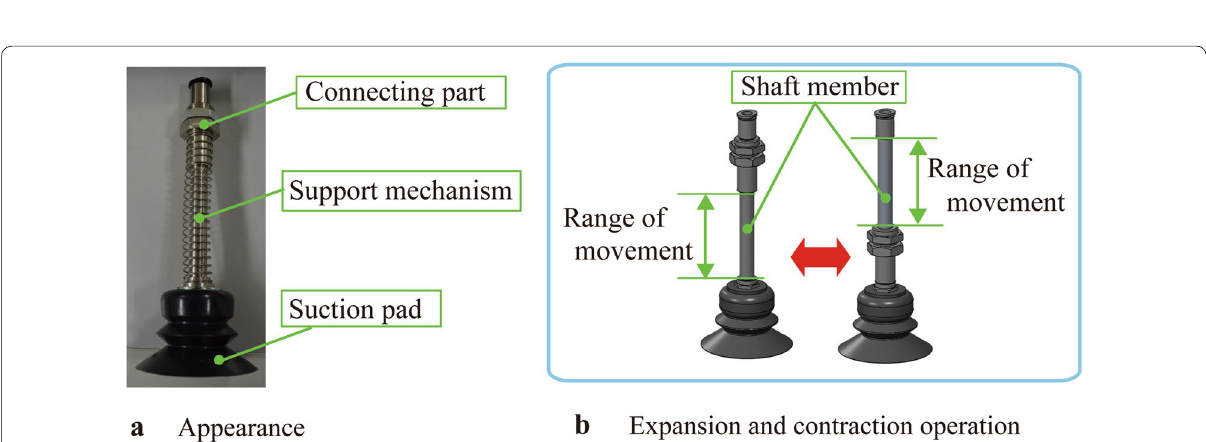
Fig. 5 Conventional suction pad units (VPC 50-50 BN 6 JC, PISCO). a Appearance, b expansion and contraction